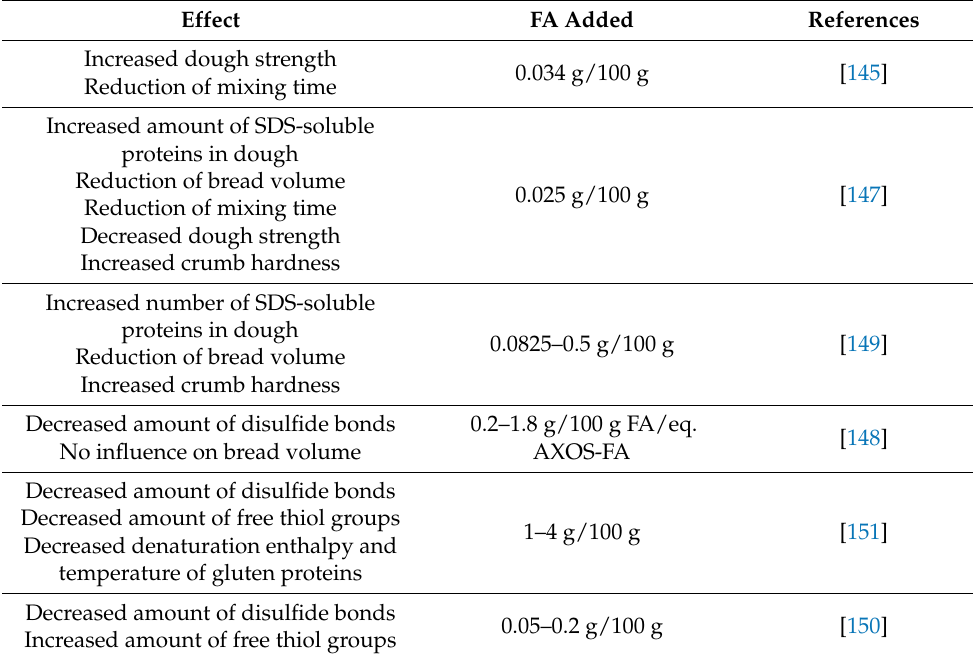
Table 2. Influence of added FA on the behavior and functionality of wheat dough and